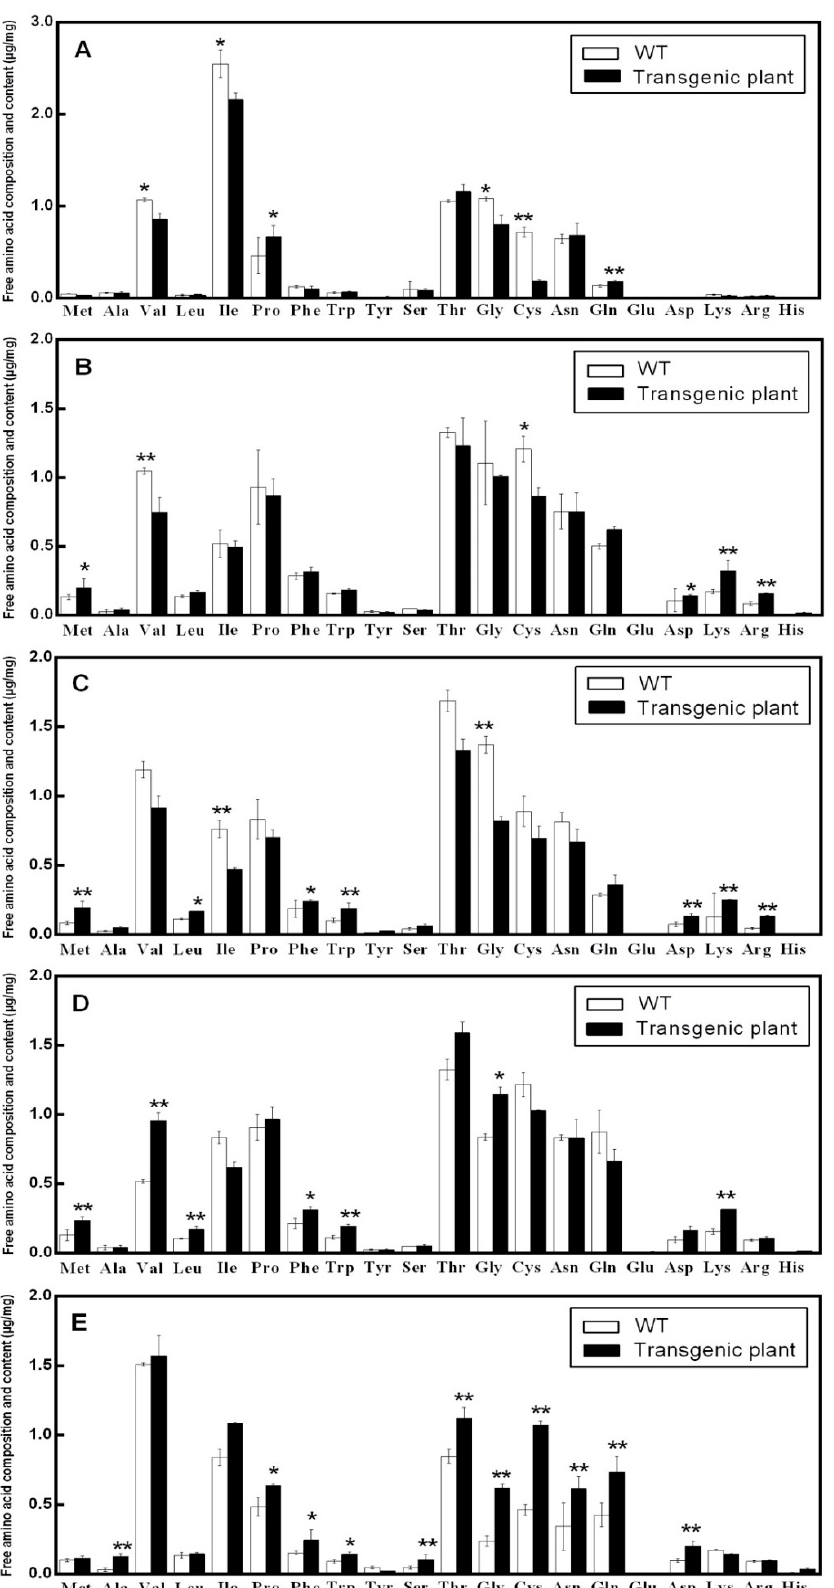
Figure 6. Contents of 20 amino acids in roots ( A ), stems ( B ), leaves ( C ), flowers ( D ), and siliques ( E ) of wild-type (WT) and transgenic plants of Arabidopsis thaliana with overexpression of AtAAP1 . Symbols “*” and “**” indicate significant differences at p values of 0.05 and 0.01, respectively.